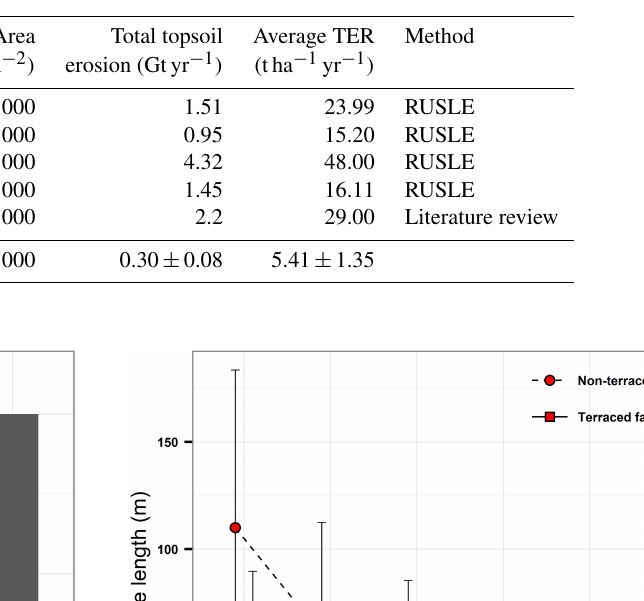
Table 2. Estimates of total topsoil erosion (Gtyr − 1 ) and average TER (tha − 1 yr − 1 ) on the CLP. Note that estimates refer to the entire surface area of the CLP (all land uses).